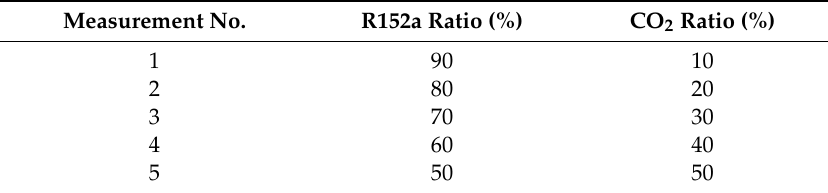
Table 7. Di ff erent mixture ratio of R152a and CO